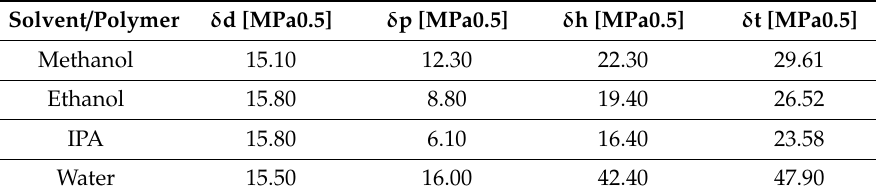
Table 1. Hansen’s solubility parameters for pure alcohols